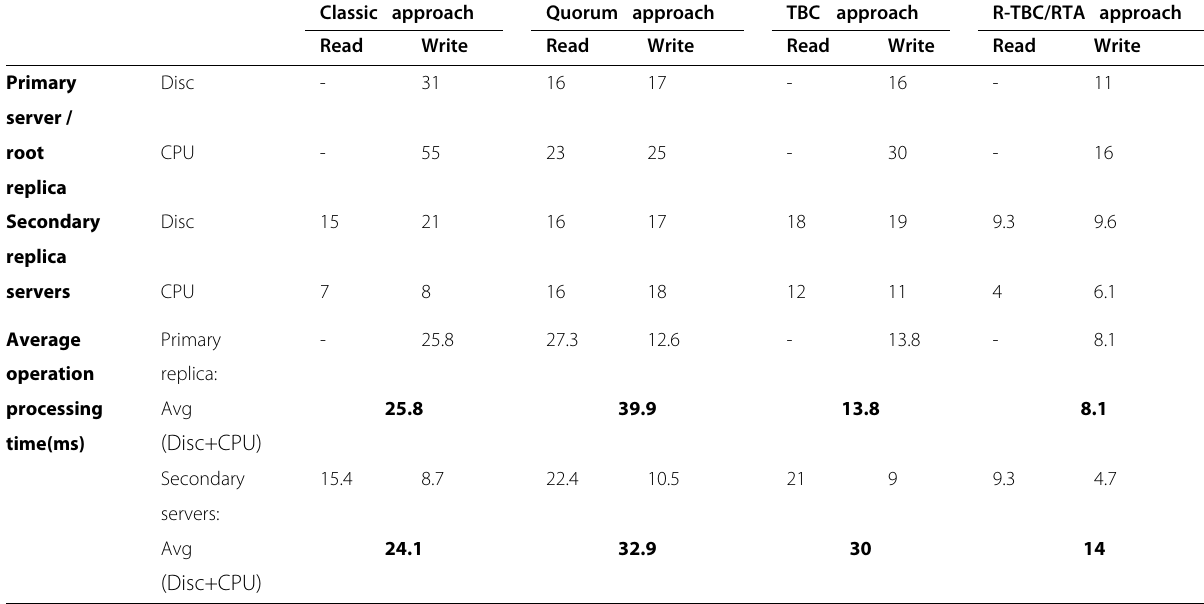
Table 2 The processing times (ms) of read/write operations (70/30 R/W ratio) for standard approaches (Classic, Quorum, TBC) and proposed advanced R-TBC/RTA approach for maintaining the consistency of the cloud DBMS Classic approach Quorum